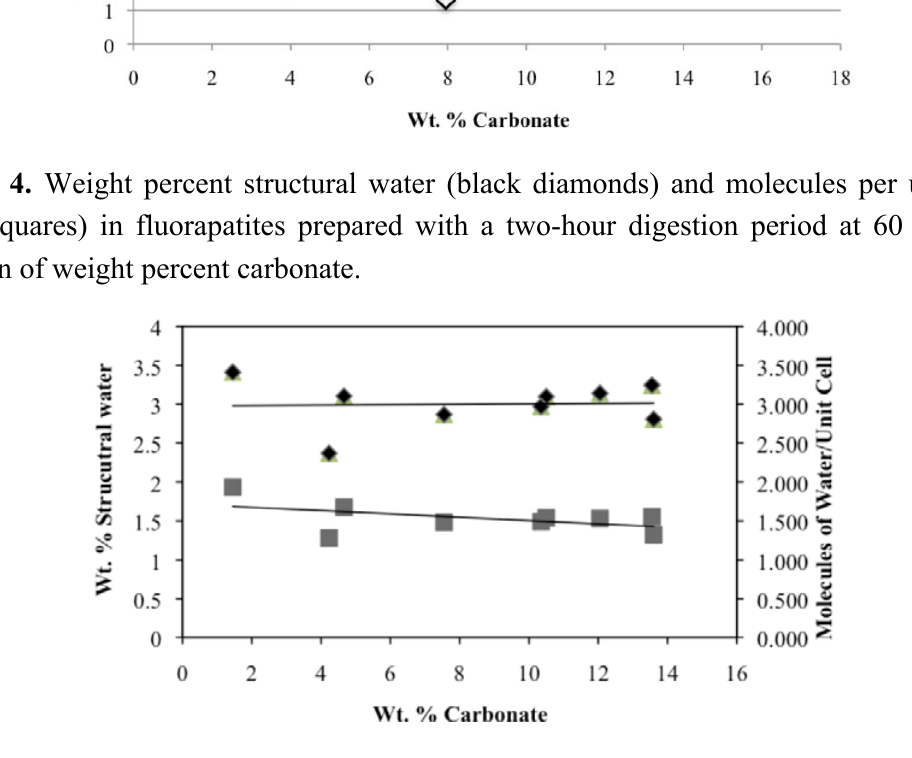
Figure 5. Weight percent adsorbed water in fluorapatites prepared with a two-hour digestion at 60 °C as a function of weight percent